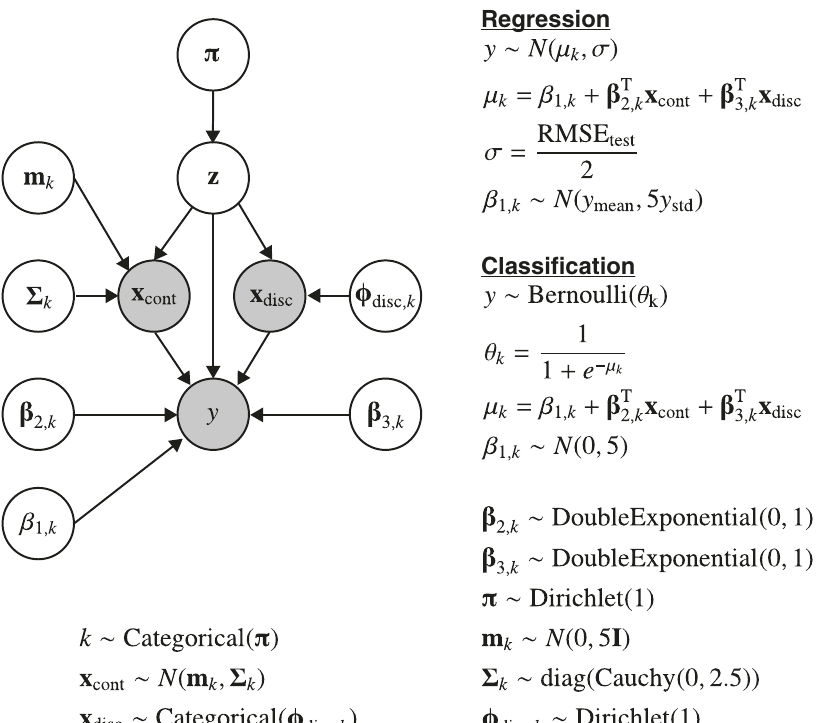
Fig. 2 Graphical model representation of stochastic surrogate model. Nodes in the graphical model are represented as follows: x cont , continuous explanatory variables; x disc , discrete explanatory variables; y , response variable predicted by the ML model; z , the parameter of the mixture components; and all the others, prior distributions. The formulation for y differs between regression and classi fi cation tasks. k represents each mixture component, and Σ k is a diagonal matrix with elements according to the Cauchy distribution. The symbol RMSE test in the equation represents a root-mean-squared error of the regression model, and y mean and y std represent the mean and standard deviation values of the predicted response variable, respectively.